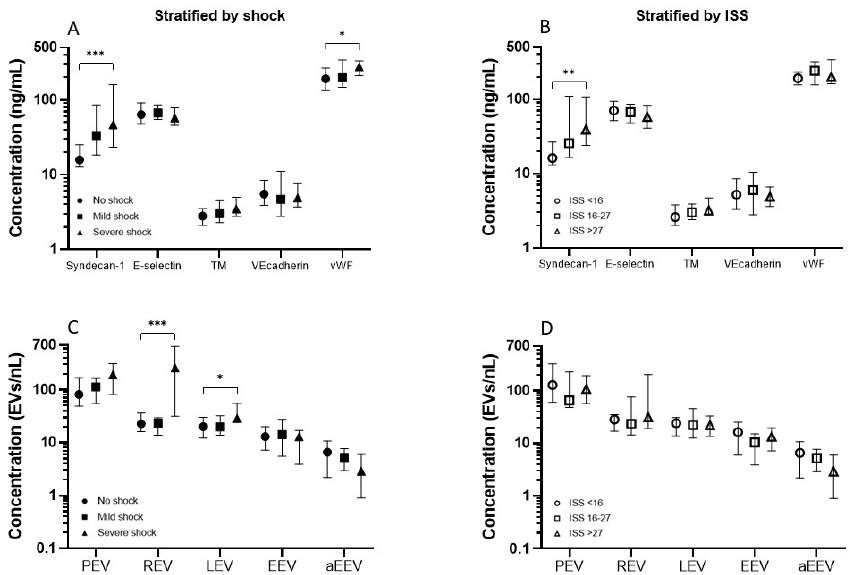
Figure 1. Median and interquartile ranges of ( A ) endothelial activation markers stratified by shock ( B ) endothelial markers stratified by injury severity score (ISS) and ( C ) Extracellular vesicles stratified by shock ( D ) extracellular vesicles stratified by ISS. A bar with asterisk represents a statistically significant difference between the groups, * p < 0.05, ** p < 0.01, *** p < 0.001. Abbreviations: TM: thrombomodulin, vWF: von Willebrand Factor, PEV: platelet derived extracellular vesicle, REV: red blood cell derived extracellular vesicle, LEV: leucocyte derived extracellular vesicles, EEV: endothelial derived extracellular vesicle, aEEV: activated endothelial derived extracellular vesicle.